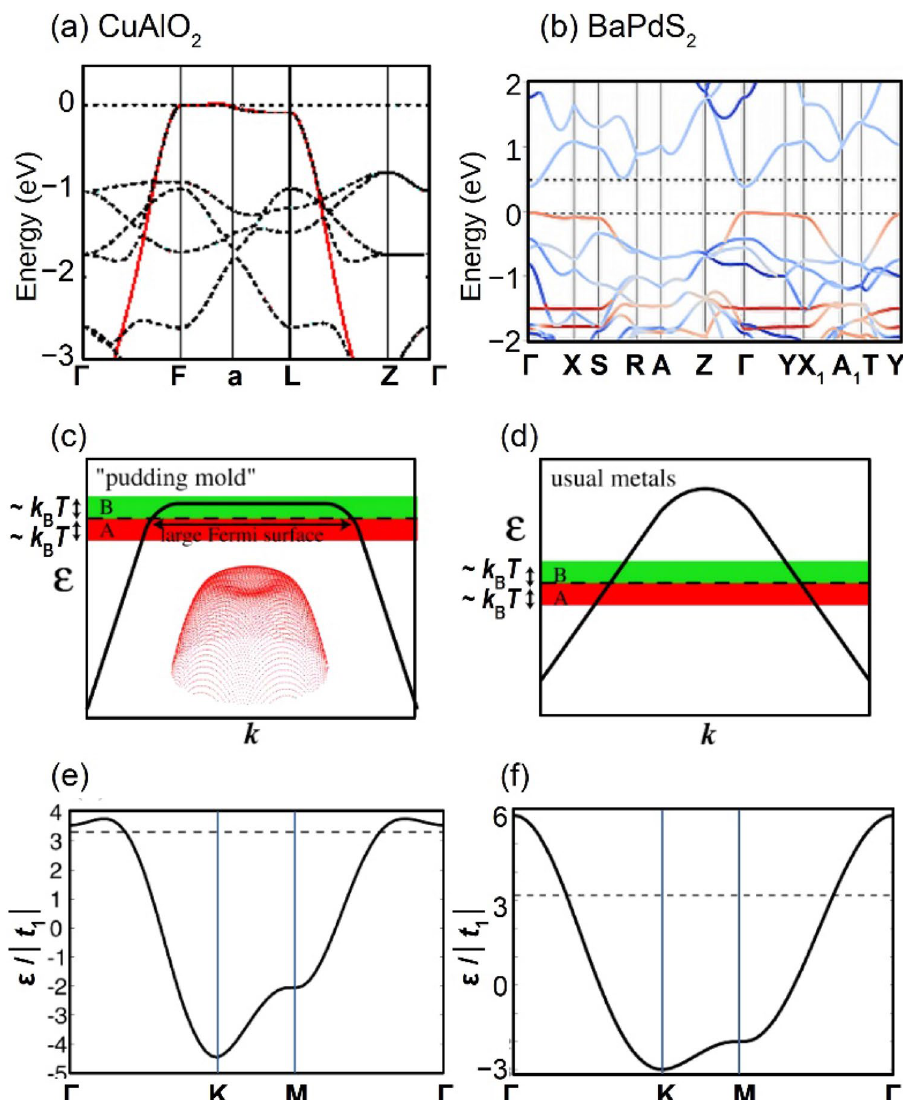
Fig. 3 The red curves in a , b show pudding-mold band struc- ture in CuAlO 2 [46] and BaPdS 2 [54], respectively. Schematic figure of the electronic structure within the pudding-mold struc- ture shown in ( c ) and compare to the one of a typical metal ( d ). Moreover, e , f represent the band dispersion [55]. Here, t 1 is the hopping integral between neighboring sites, and ε is the quasiparticle energy. The dotted gray lines mark the position of the chemical potential for a given temperature T . Adapted with permission from Refs. [46, 54, 55]. Copyrights 2013,